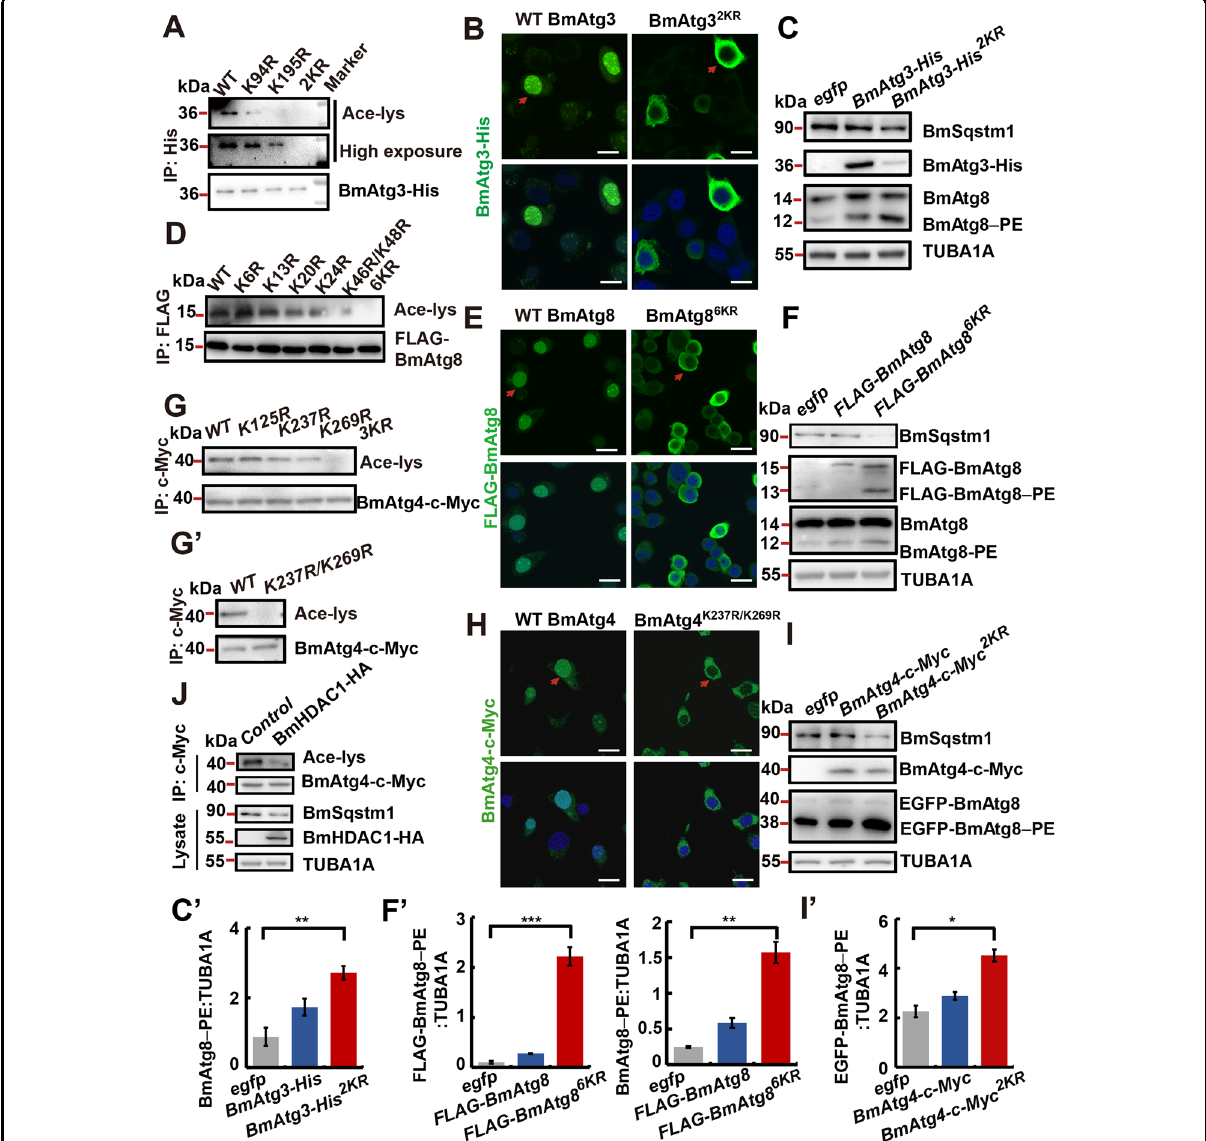
Fig. 6 Authenticity and autophagic activities of identi fi ed acetylation sites in BmAtg3, BmAtg4, and BmAtg8. A Acetylation level of BmAtg3 after single and double mutation of acetylation sites. 2KR: double acetylation-site mutated from lysine (K) to arginine (R). B Immuno fl uorescent staining of BmAtg3 double acetylation-site mutant. Scale bar: 10µm. C – C ′ Protein levels of BmSqstm1, BmAtg8, and BmAtg3 after overexpression of double acetylation-site mutated BmAtg3 under nutrient-rich conditions ( C ). Quanti fi cation of BmAtg8 – PE in C (C ′ ). Signi fi cance test was performed between egfp and mutant overexpression. D Acetylation level of BmAtg8 after single and sextuple mutation of acetylation sites. E Immuno fl uorescent staining of BmAtg8 after sextuple mutation of acetylation sites. 6KR: sextuple acetylation site mutation from lysine to arginine. Scale bar: 10µm. F – F ′ Protein levels of BmSqstm1, FLAG-BmAtg8, and endogenous BmAtg8 after overexpression of sextuple acetylation-site mutated BmAtg8 under nutrient-rich conditions ( F ). Quanti fi cation of BmAtg8 – PE and EGFP- BmAtg8 – PE in F (F ′ ). G – G ′ Acetylation of BmAtg4 after single and triple ( G ), or double (G ′ ) mutation of acetylation sites. H Immuno fl uorescent staining of BmAtg4 after double mutation of acetylation sites. Scale bar: 10µm. I – I ′ Protein levels of BmSqstm1 and EGFP-BmAtg8 after overexpression of double acetylation-site mutated BmAtg4 under nutrient-rich conditions ( I ). Quanti fi cation